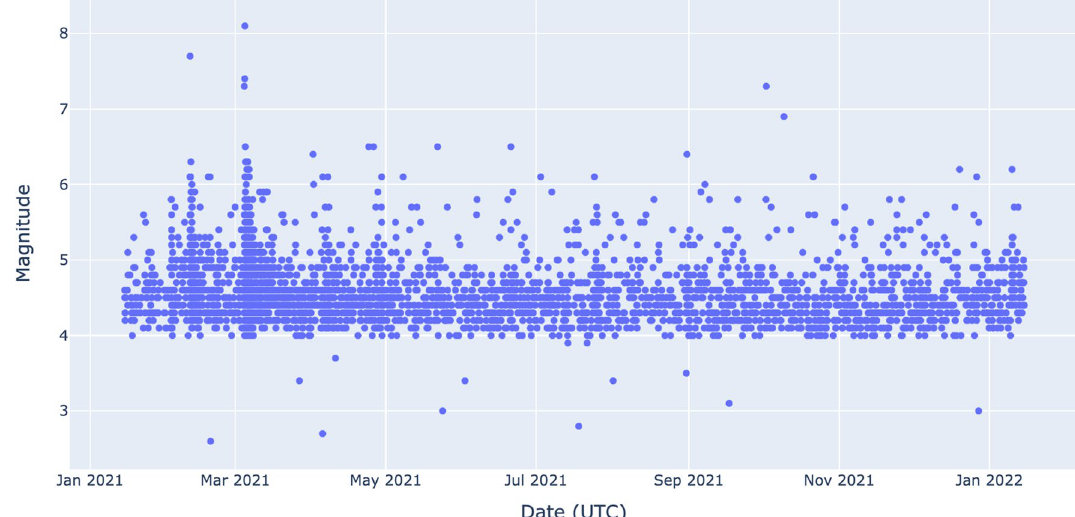
Fig. 4 There were 3,773 earthquakes around Tonga (170.0 E, 160.0 W, 10.0 S, 45.0 S) between 15 January 2021 and 14 January